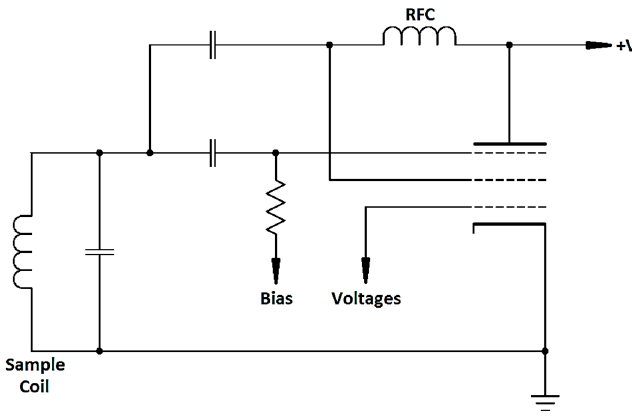
Figure 12. A simple frequency sweep magnetometer.